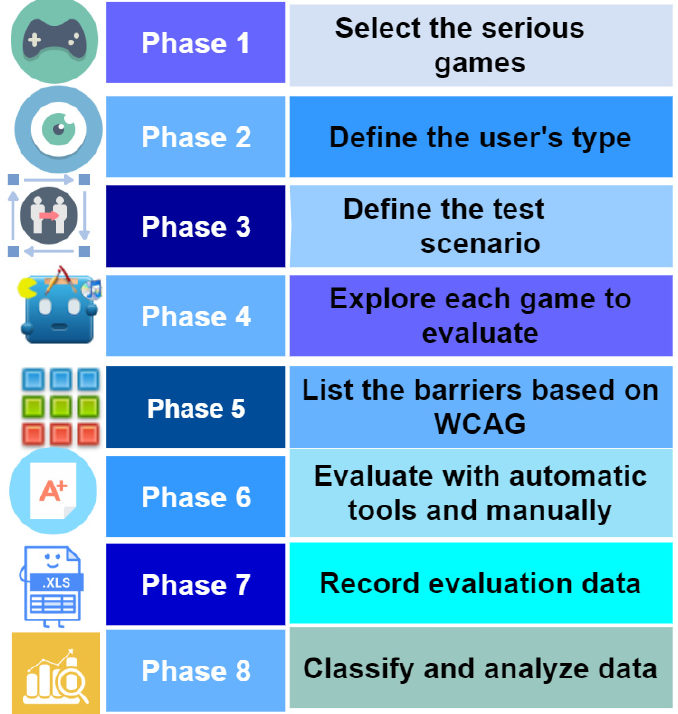
Figure 1. Diagram of accessibility evaluation of serious games.